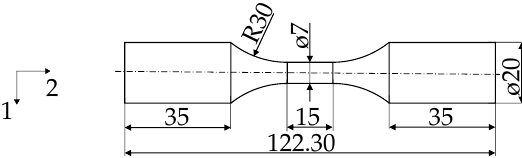
Figure 3. Geometry and dimensions (in mm) of the unnotched fatigue test